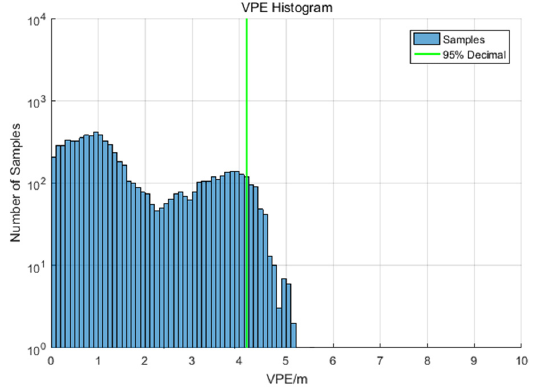
Figure 10. The HPE histogram of flight test-I. The green line in the figure is the horizontal accuracy (95%), which is 1.62 m.